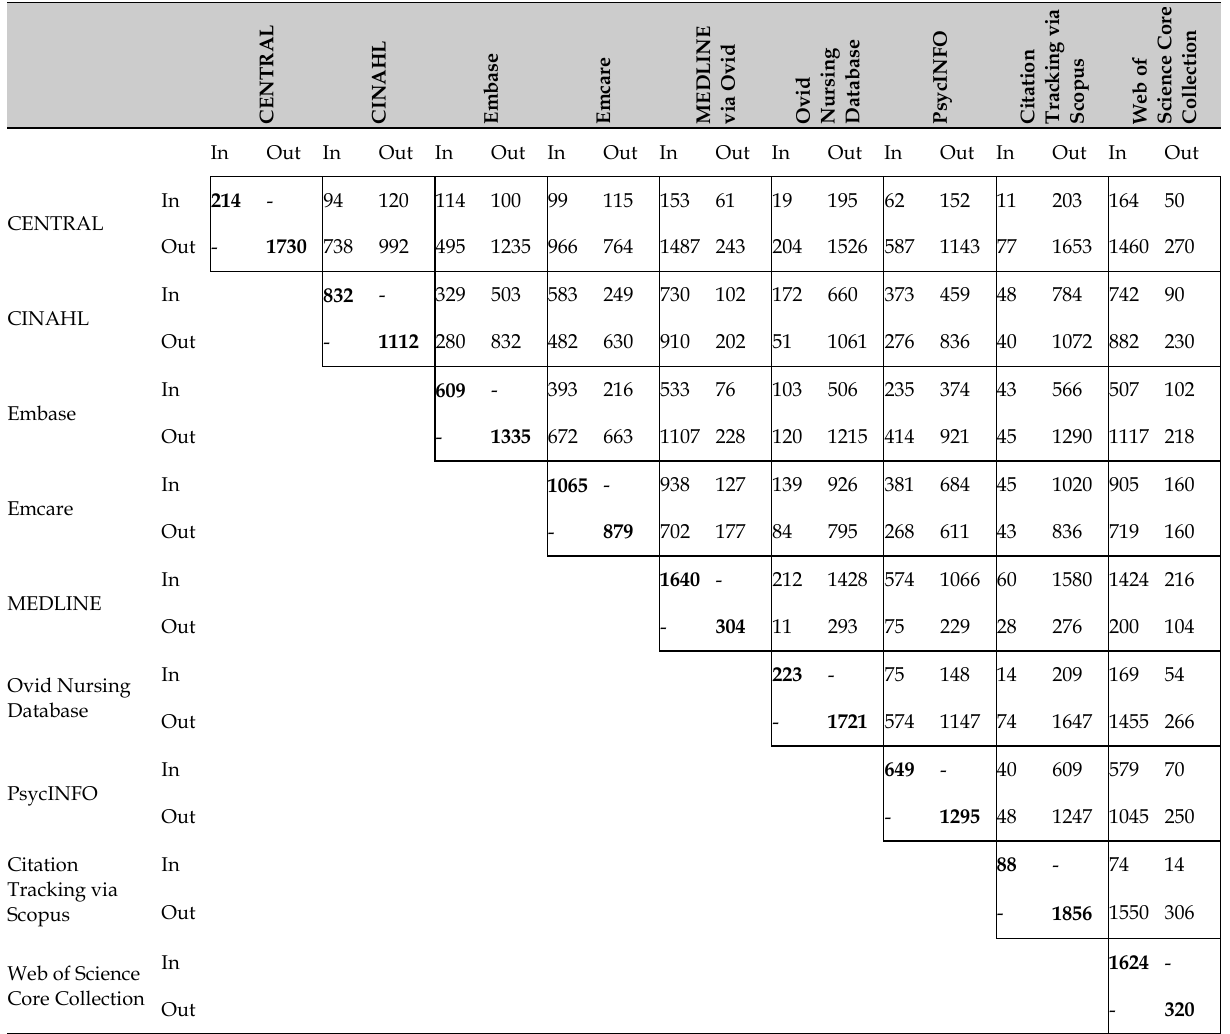
Table 3 Database overlaps of indexed (In) and non-indexed (Out) cases among retrieved duplicate cases